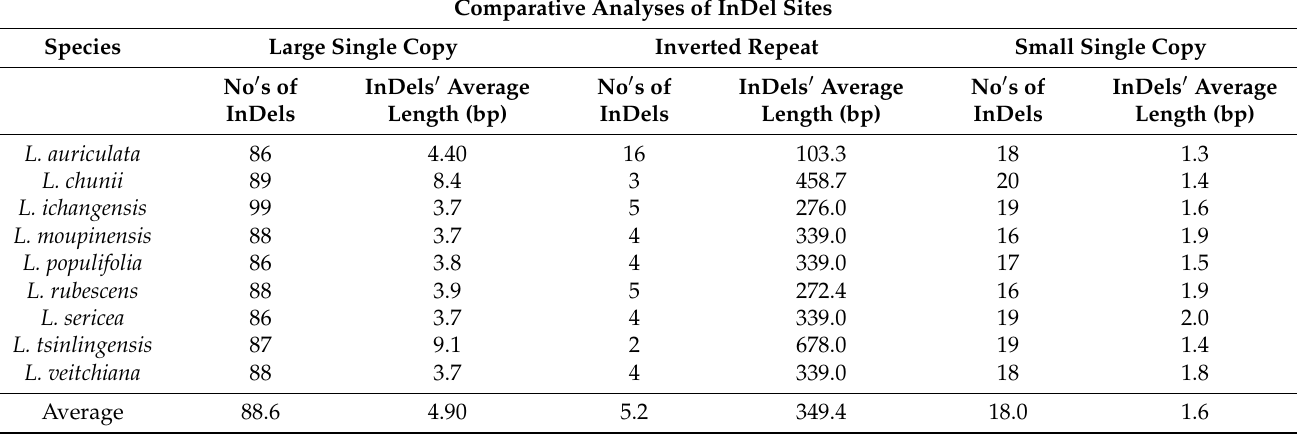
Table 4. Comparative analyses of the number and average length of InDel sites in LSC, SSC, and IR regions in the complete cp genomes of nine species of